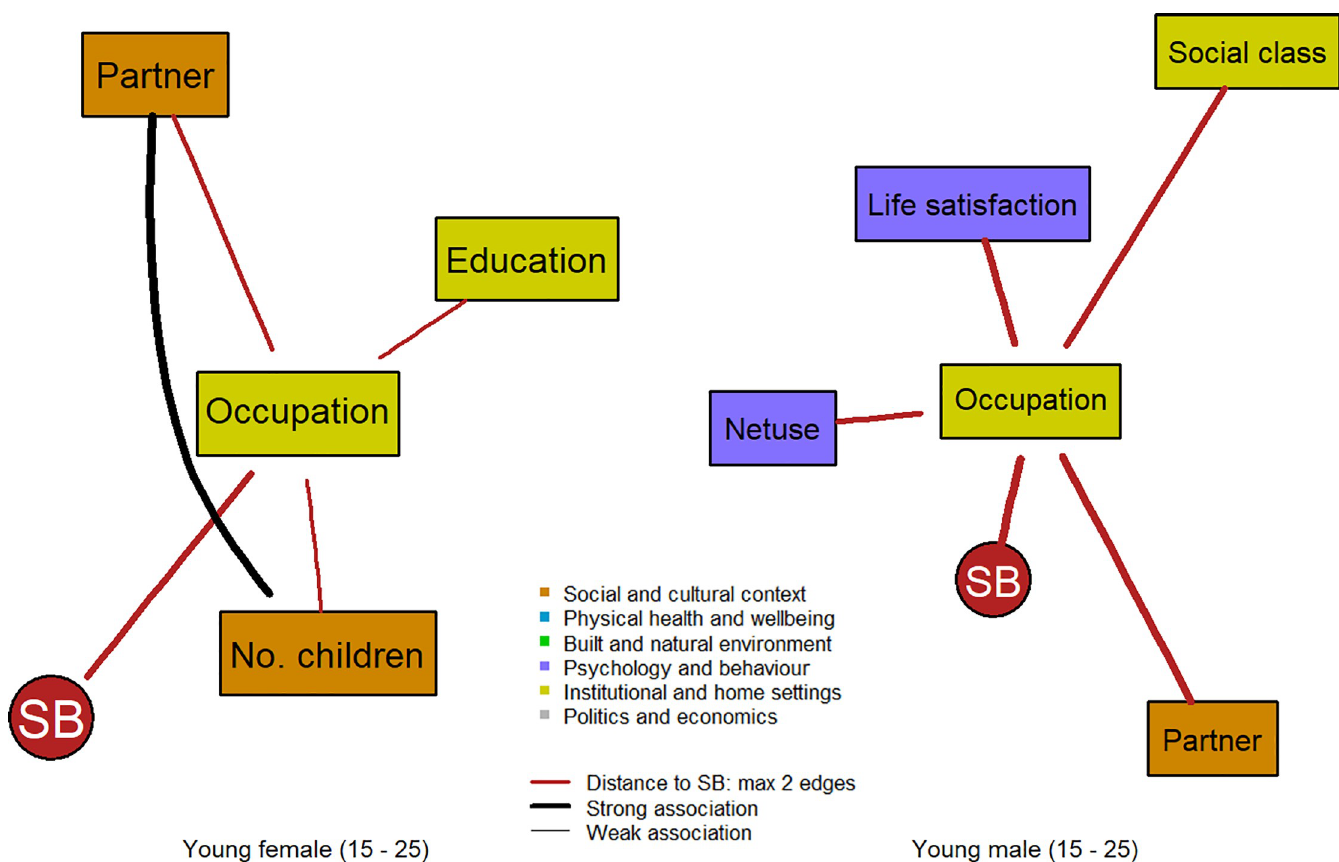
Fig 2. Factors linked to SB within two edges distance in the subgraphs for young females (2a: left; N = 1,218) and young males (2b: right; N = 1,144).